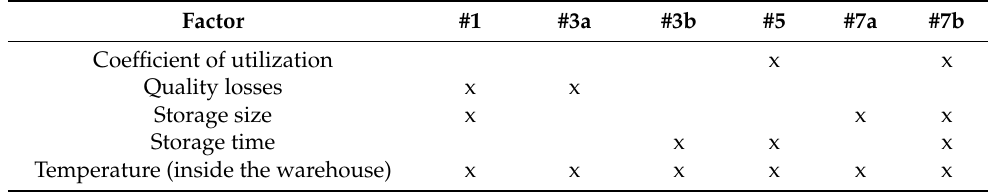
Table 2. Factors affecting the specific energy consumption of the different